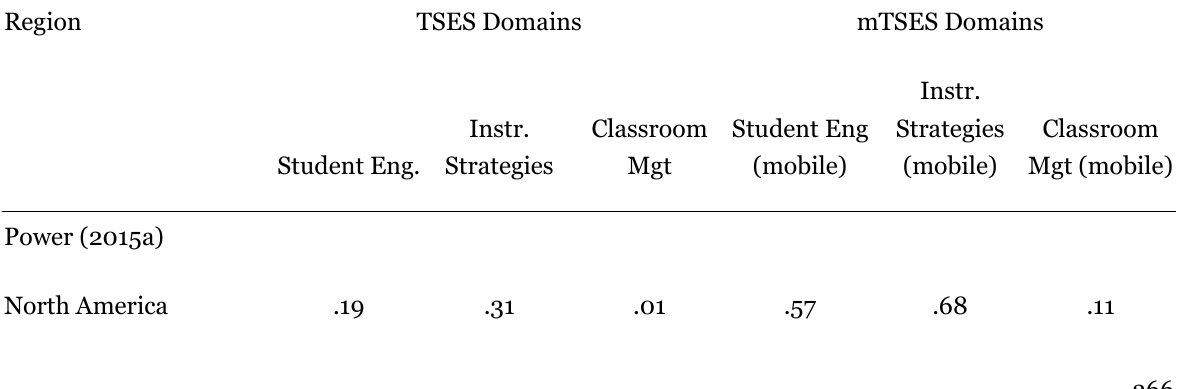
Changes in TSES and mTSES Scores by Region Region TSES